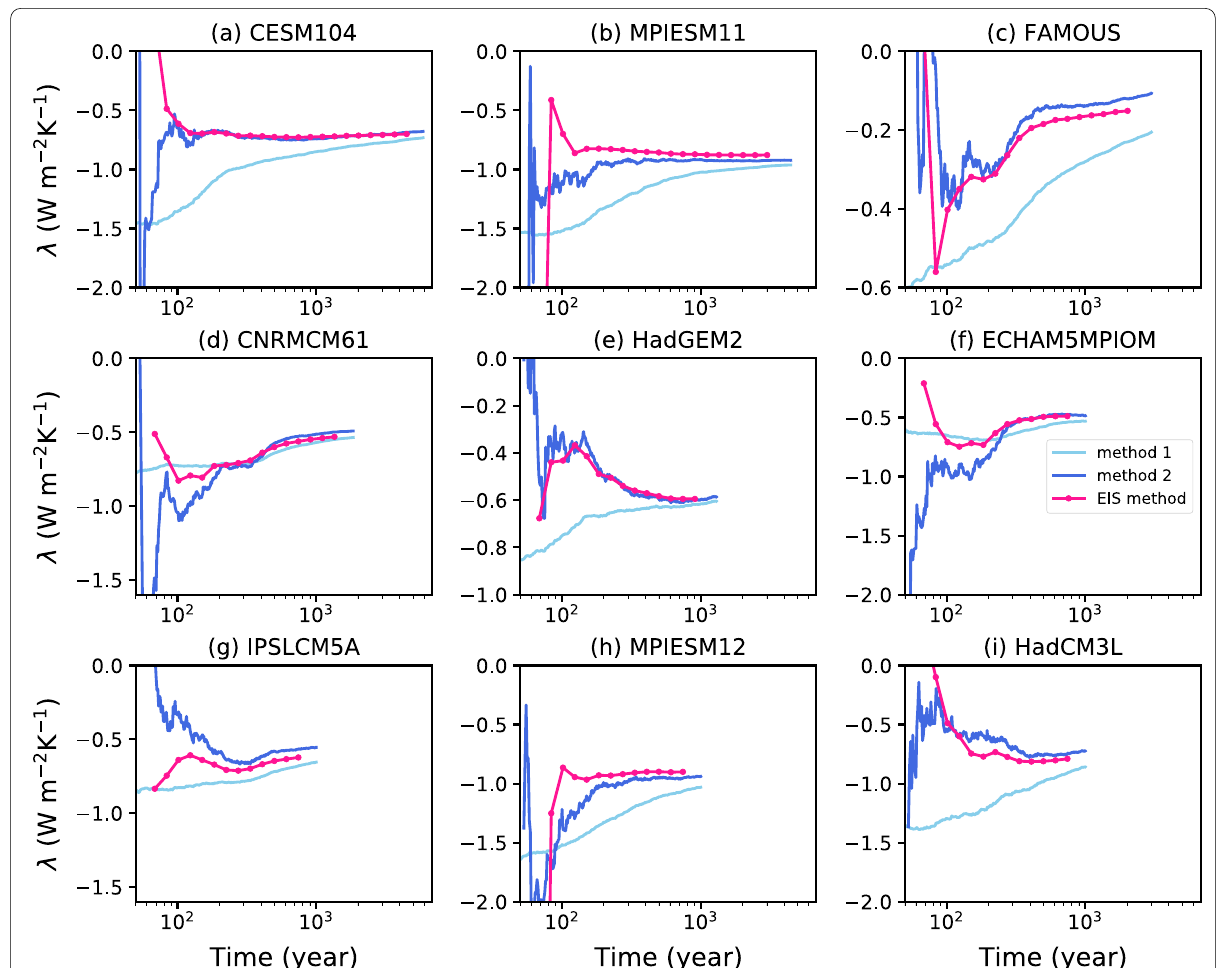
Fig. 4 Time series of the climate feedback (cid:31) (the d N /d T slope of the linear fit on the global-mean and annual-mean surface temperature anomalies (cid:31) T and TOA net radiative flux anomalies (cid:31) N ) estimated from three methods. The light (dark) blue line is the (cid:31) estimated from the linear fit from the 1st (50th) to the plotted year in the original series. The deep pink line is the (cid:31) estimated from the linear fit from point 21 to the point whose upper limit of the average range is around the plotted year in the new